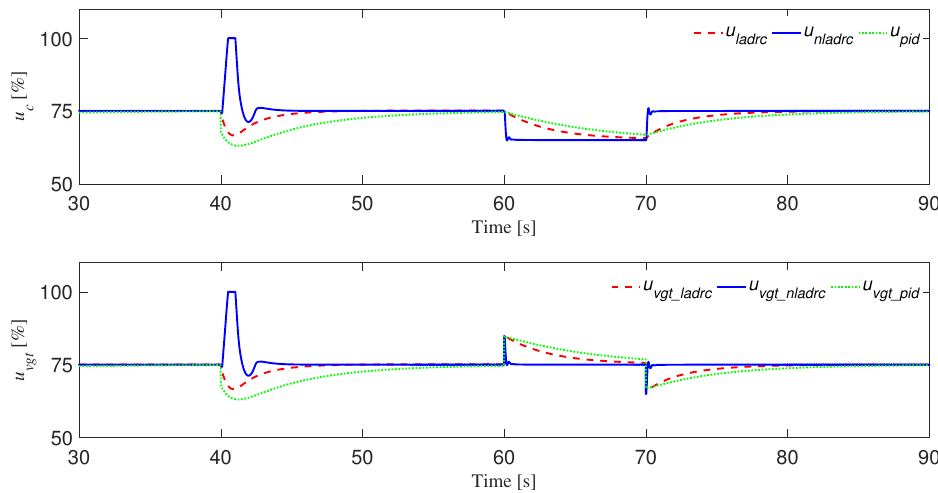
Figure 7. Response curve of intake manifold pressure p im after adding square wave form control disturbance.